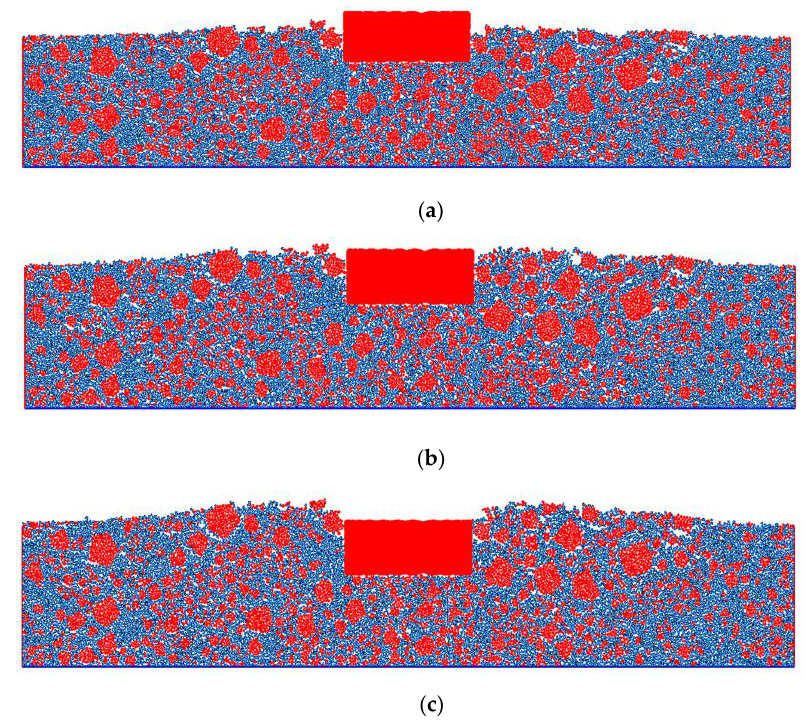
Figure 9. ( a ) Rutting deformation of the virtual track test at 110 min. ( b ) Rutting deformation of the virtual track test at 220 min. ( c ) Rutting deformation of the virtual track test at 328 min.